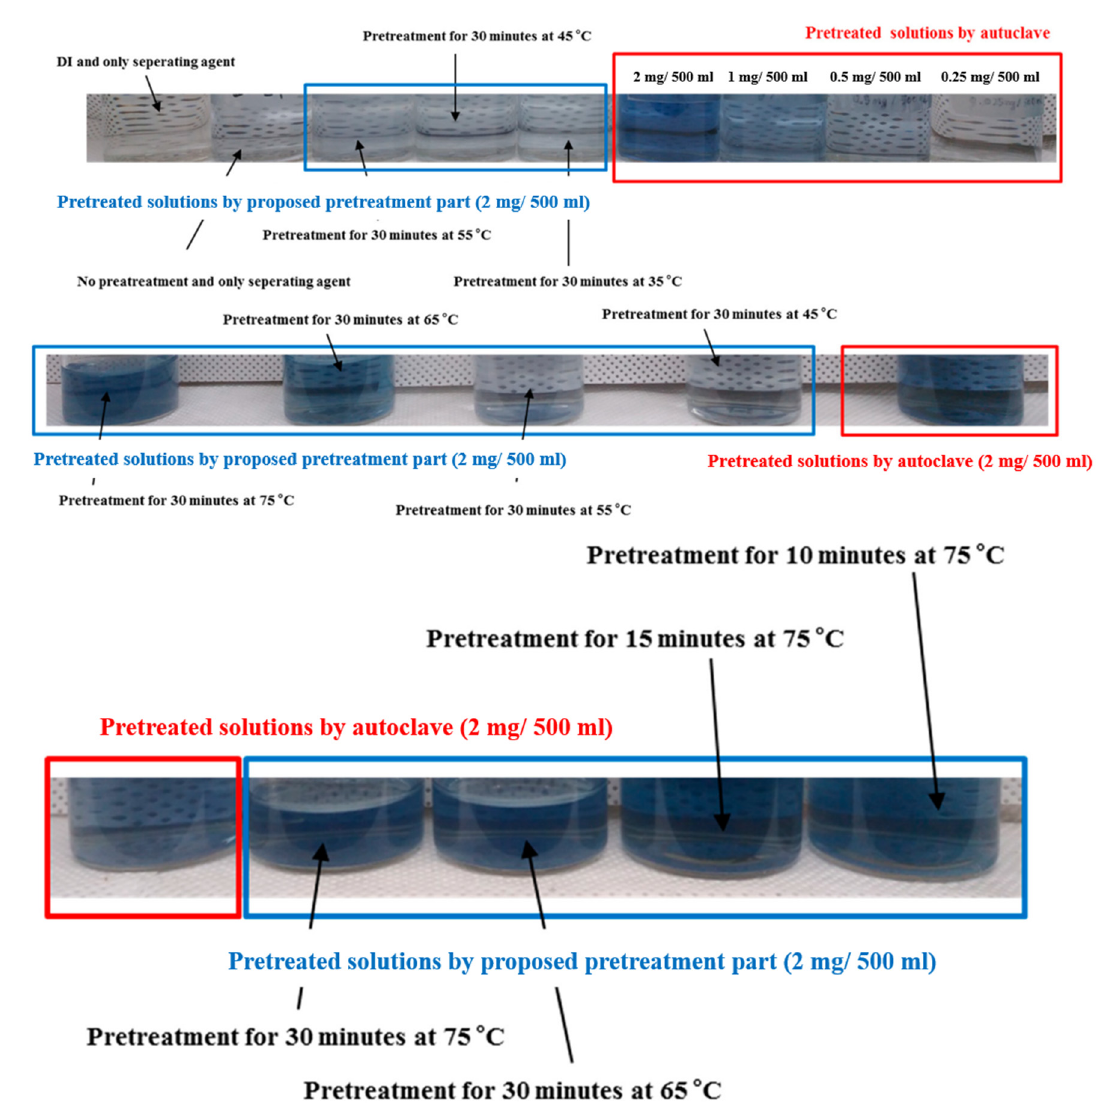
Figure 8. Comparison of the pretreatment performance between the proposed TP pretreatment microfluidic chip and the conventional pretreatment equipment.